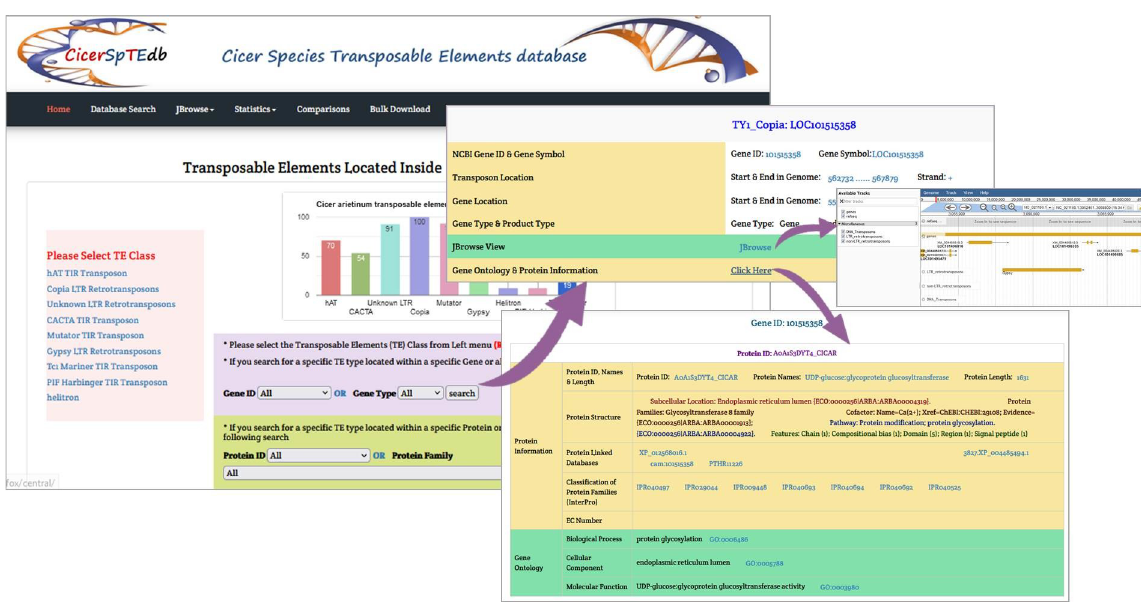
Fig 8. CicerSpTEdb’s search page for TEs located within